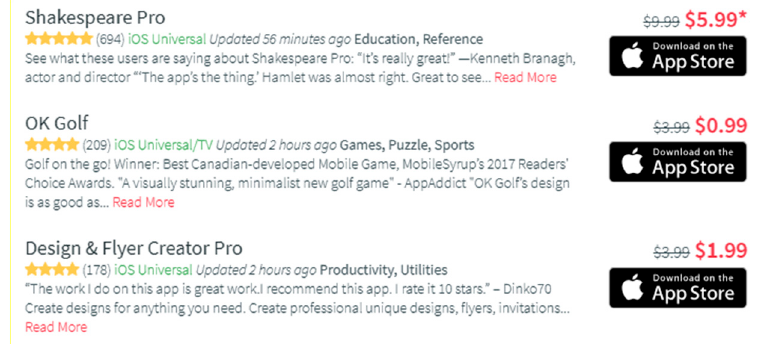
Figure 7. Three paid Apps https://appsliced.co.